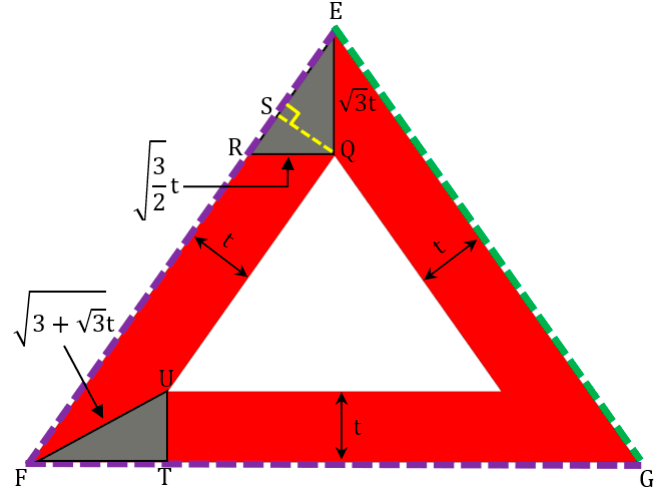
Figure 6. Cross-section of the pyramid over the green and purple dashed line or through F, E and G. The grey triangles ∆ EQR and ∆ TUF are used to calculate the lengths and ratios between the edges.